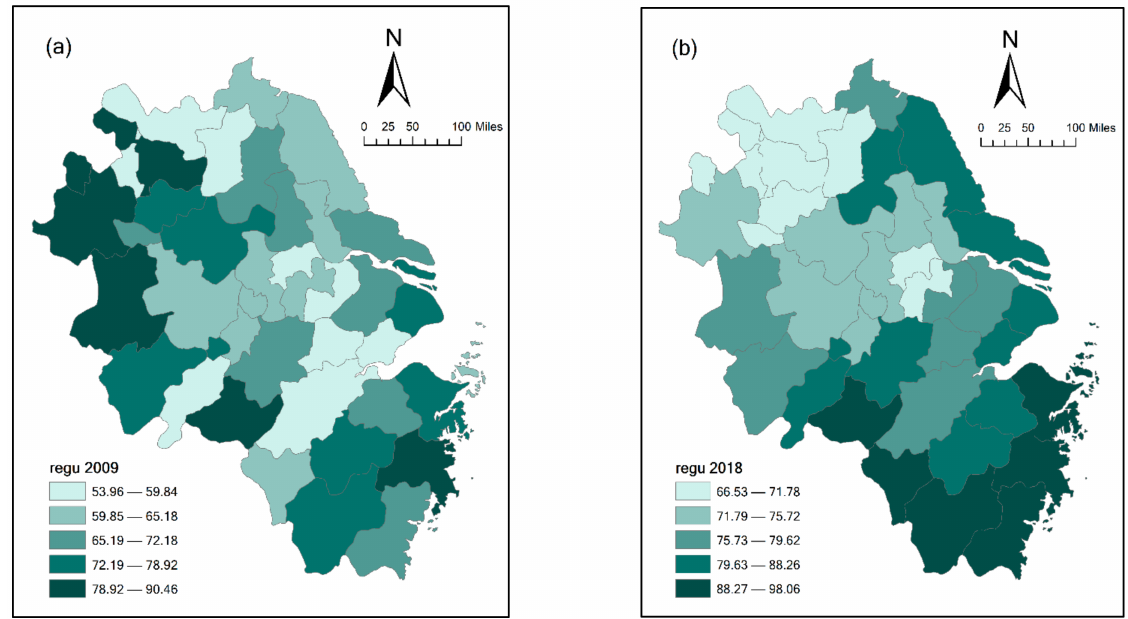
Figure 4. Spatial heterogeneity diagram of environmental regulation:( a ) year 2009, ( b ) year